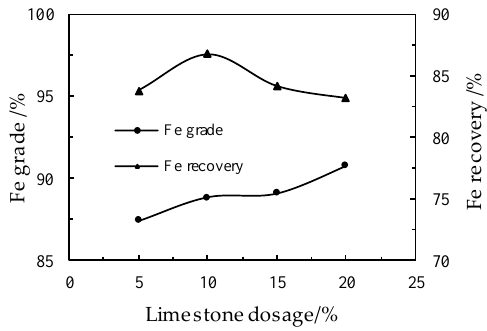
Figure 3. Effect of limestone dosage on the DR process.